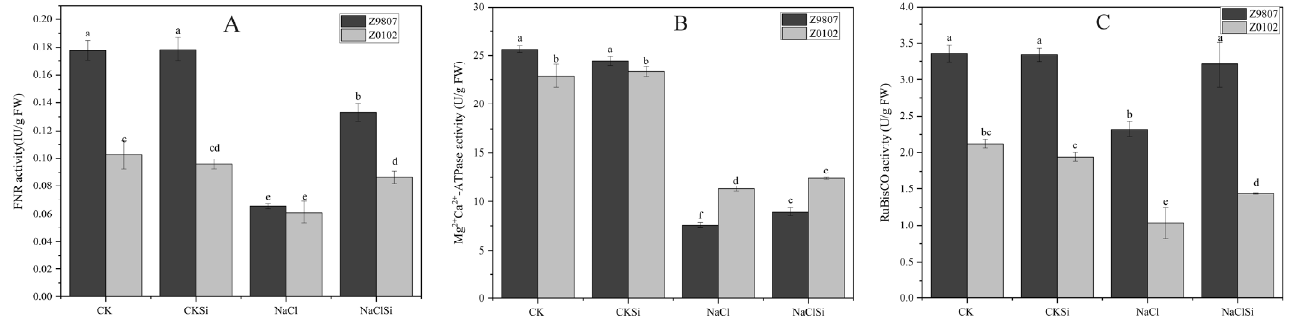
Figure 11. Effects of Si on the activity of enzymes related to photosynthesis. ( A ) FNR activity; ( B ) Mg 2+ Ca 2+ -ATPase activity; ( C ) RubisCO activity. Bars represent the mean ± SD ( n = 3). FNR, ferredoxin-NADP oxidoreductase; RubisCO, ribulose-1, 5-bisphosphate carboxylase/oxygenase. Different letters mean significantly different among treatments at p ≤ 0.05.